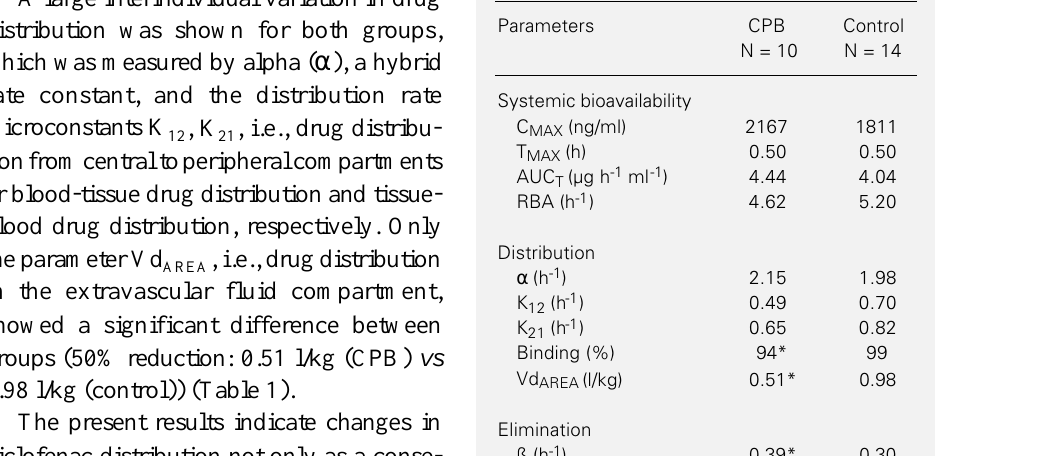
Table 1 - Effect of cardiopulmonary bypass (CPB) on systemic bioavailability, distribution and elimi- nation of